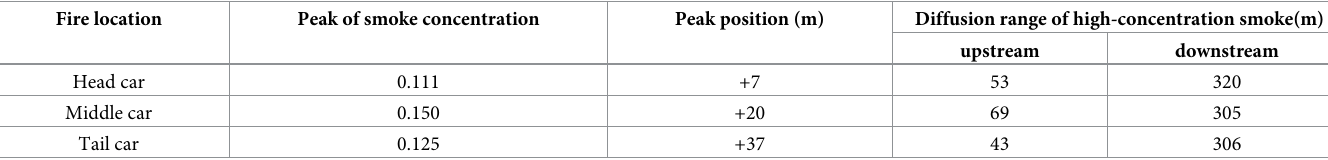
Table 5 lists the peak values of smoke concentration and the diffusion distances of highly concentrated smoke at t = 250 s for different fire locations. Furthermore, the diffusion distance of highly concentrated smoke upstream is the longest when the middle car is burning. It is 30.19% and 60.47% longer than that for the head and tail car fires, respectively.